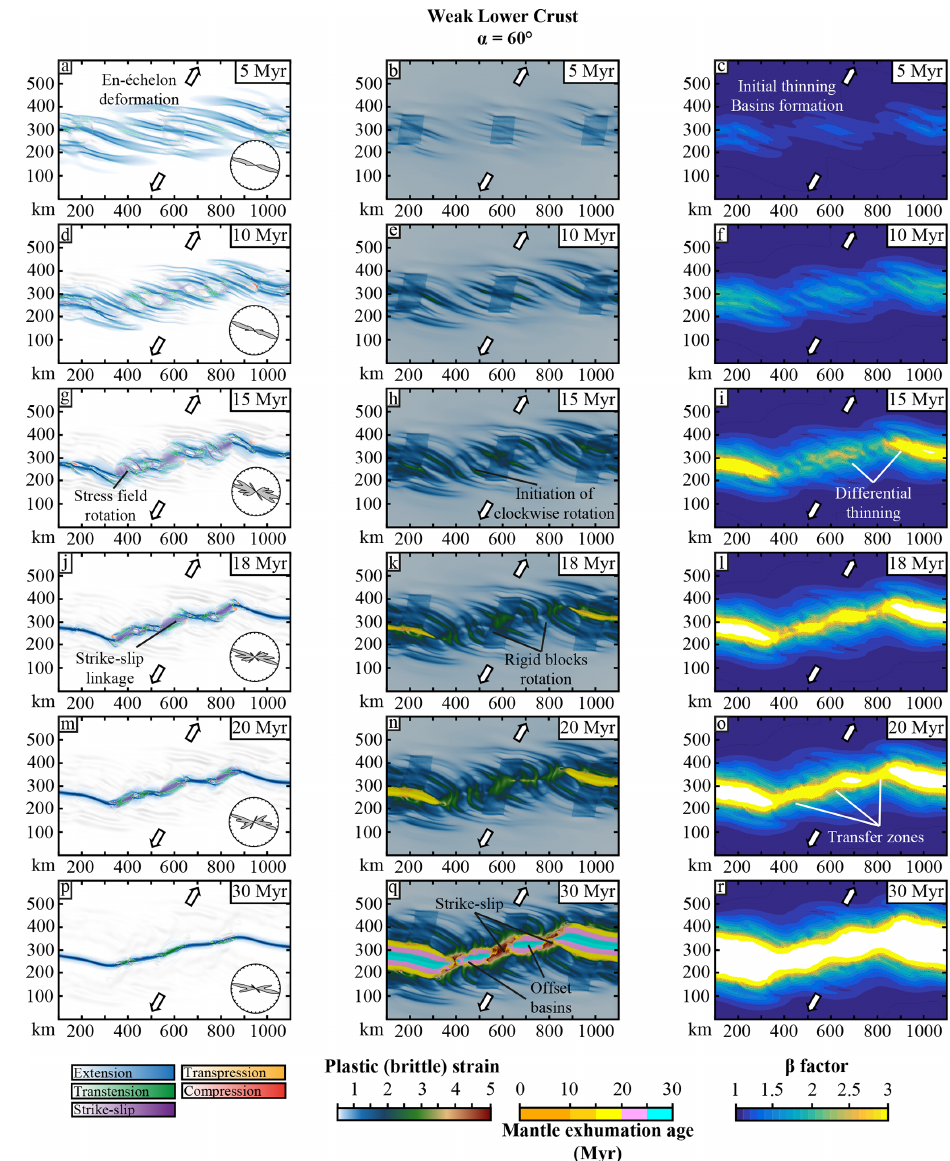
Figure 3. Model 1, weak lower crust, α = 60 ◦ , map views. Left column: active strain regime; the intensity of the colours depends on the intensity of the second invariant of the strain rate. The background represents the topography with hill shading. The inset plot represents the strike of shear zones. Central column: plastic strain computed from Eq. (A6) in the crust and exhumation ages of the mantle below the 800 ◦ C isotherm. Right column: beta factor of the crust computed with Eq.